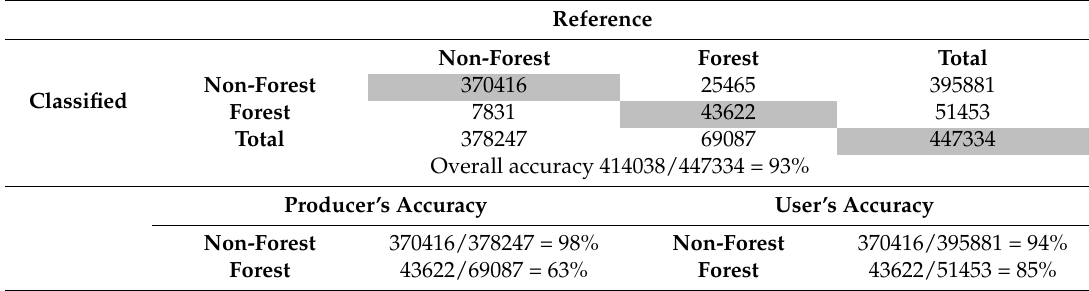
Table 1. Confusion matrix for assessing the percentage classification accuracy of the forest detection algorithm. Values in the table refer to the number of pixels for each class.